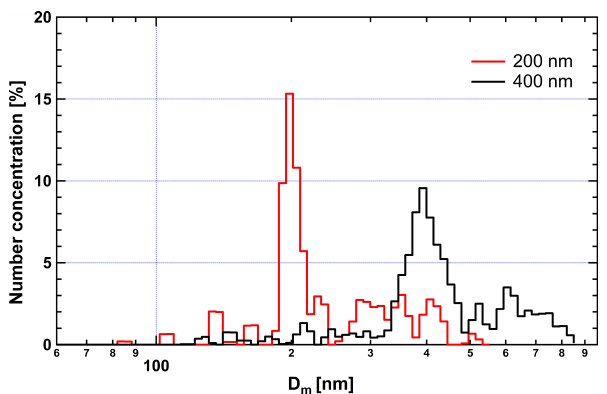
Figure A3. Number size distribution in terms of particle concen- tration percentage as a function of mobility diameter ( D m ) for 200 and 400nm size-selected mCASTblack bare soot particles.